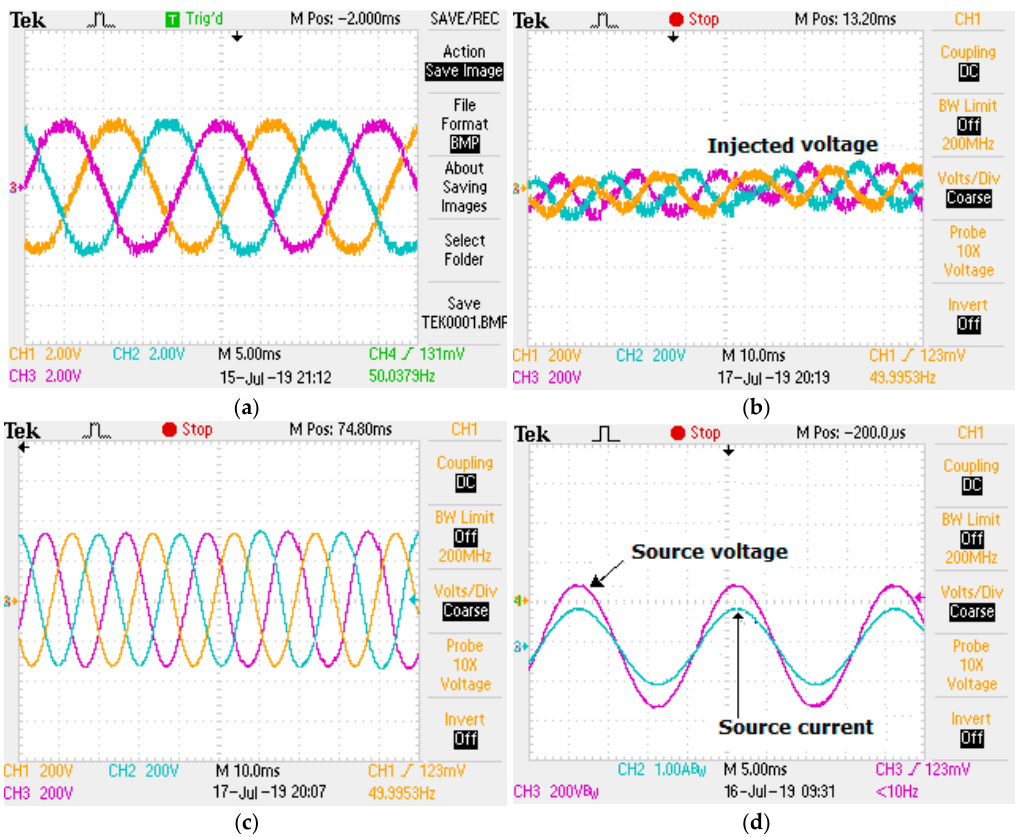
Figure 14. Experimental results: (a) source current after connecting QZSI-UPQC; (b) injected voltage; (c) load voltage; and (d) source current and source voltage.